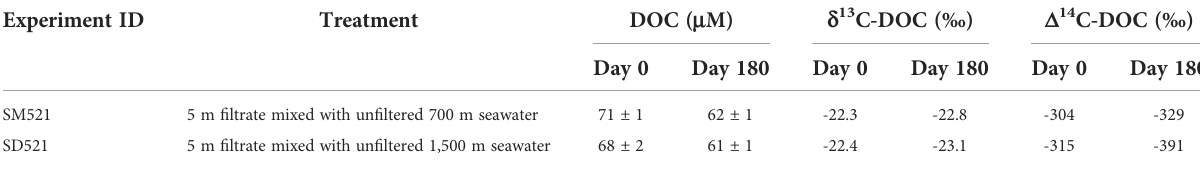
TABLE 1 Concentration of DOC and its isotopic values measured at the beginning (Day 0) and end (Day 180) of the two laboratory incubation experiments using seawater collected from the SEATS site. Experiment ID